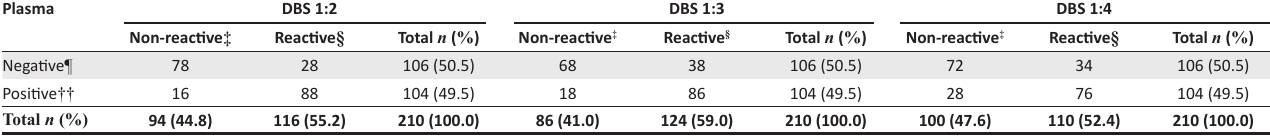
TABLE 1: HSV-2 seropositivity for plasma-based and DBS dilution-based assays using the Kalon ELISA HSV2 assay among young women in Uganda, 2004–2005. †